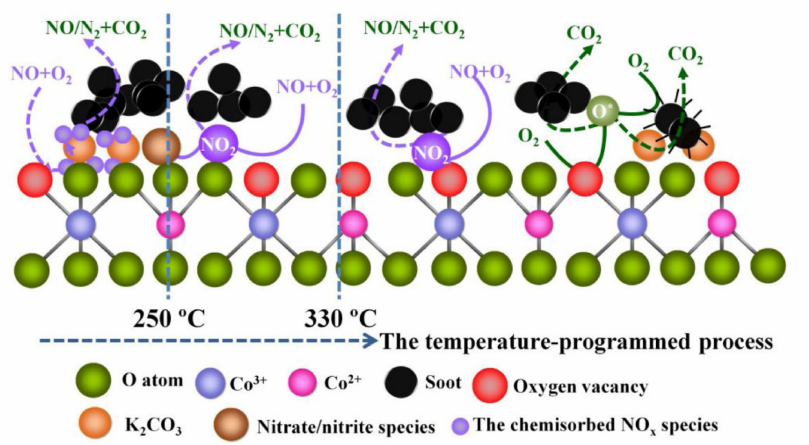
Figure 11. Reaction mechanism for soot oxidation on KCo-NW catalysts under NO/O 2 atmo- sphere [121]. Copyright 2017, Elsevier.